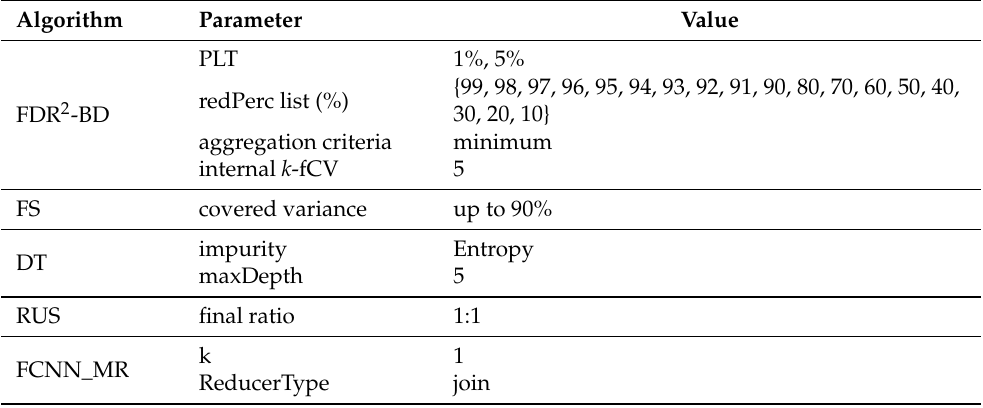
Table 3. Algorithms and